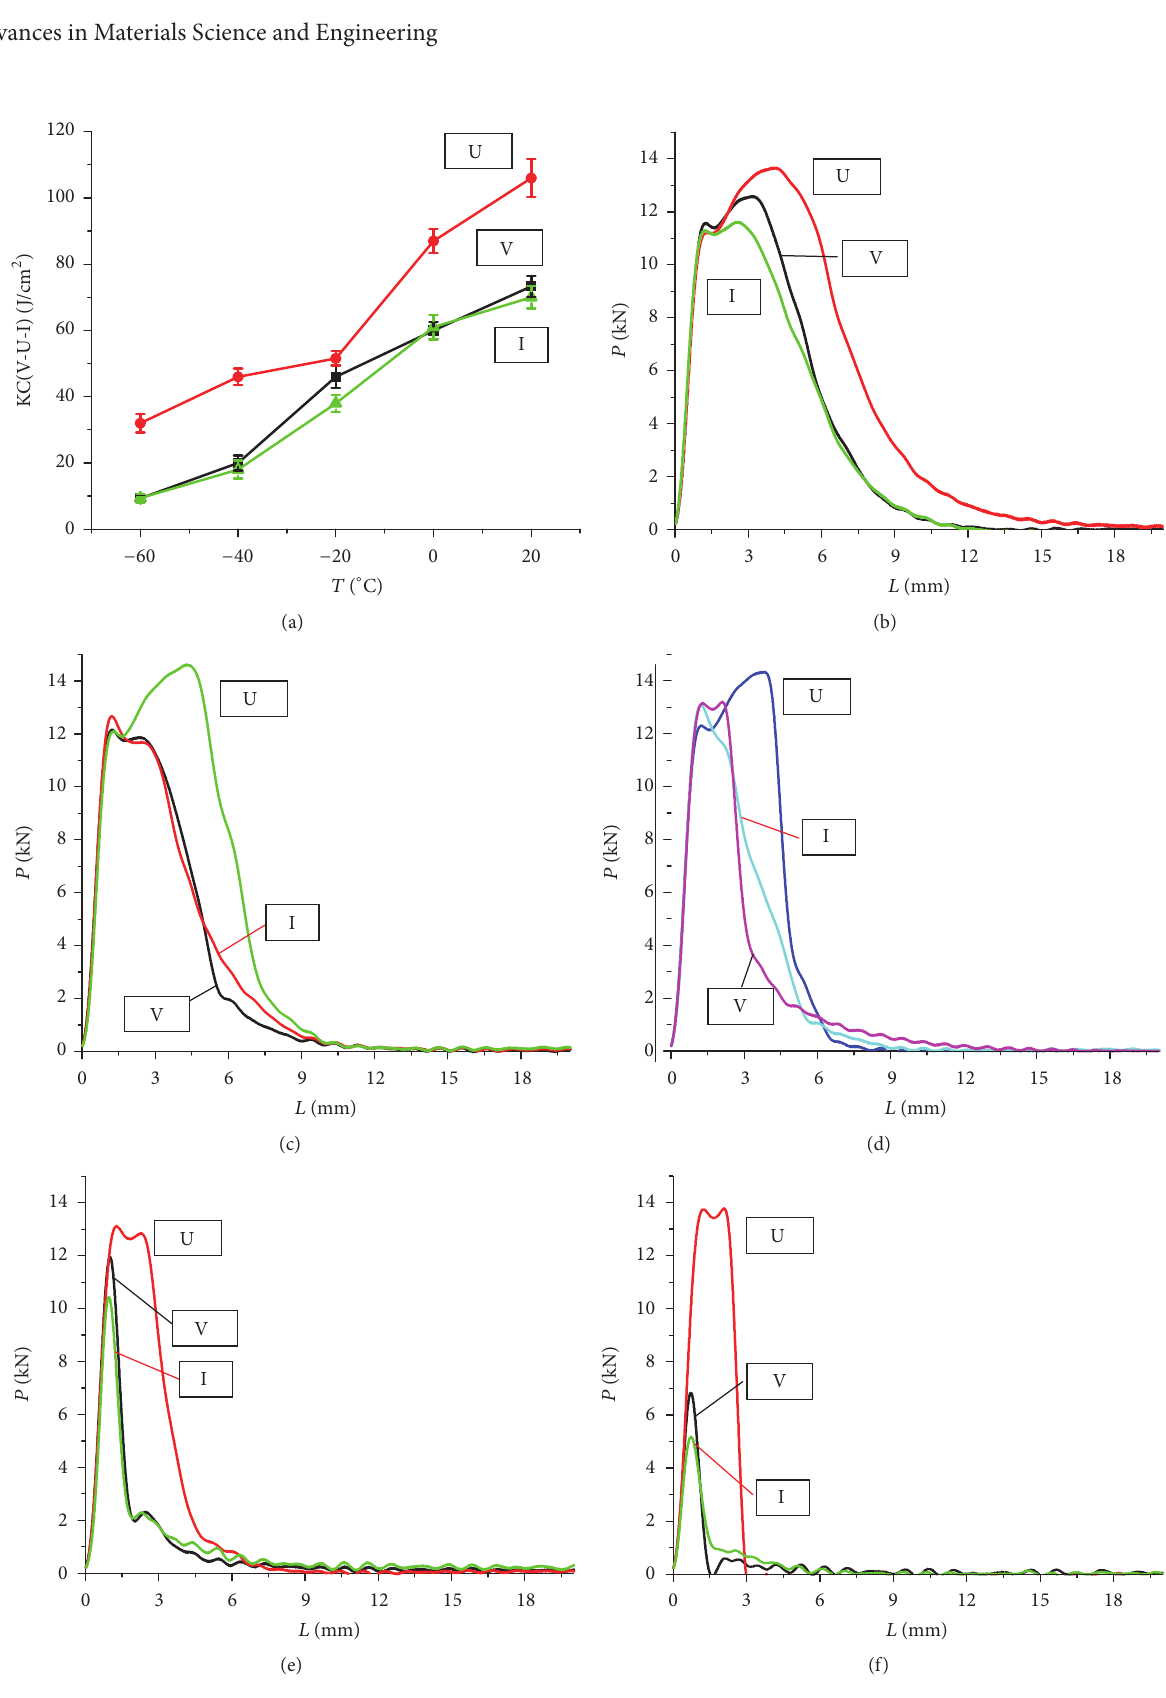
Figure 1: Temperature dependence of impact toughness (a); impact diagrams in the load/displacement coordinates at test temperatures: 20 (b), 0 (c), − 20 (d), − 40 (e), and − 60 ∘ C (f) for V-, U-, and I-notched